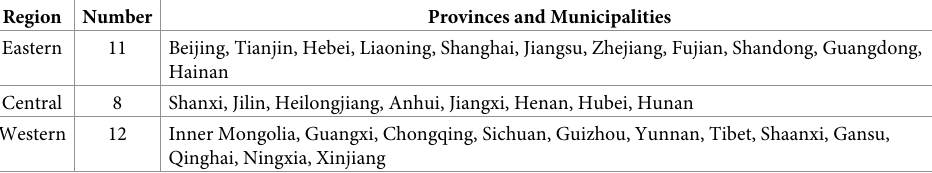
Table 3. Categorization of the 31 provincial administrative regions in